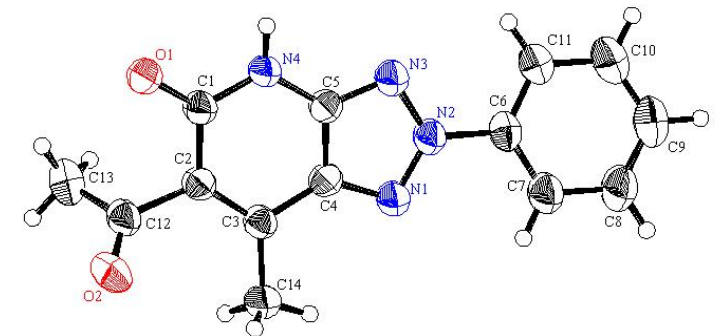
Figure 3. ORTEP plot of the x-ray crystallographic data determined for 20f . Crystallo- graphic data have been deposited in the Cambridge Crystallographic Data Centre as supplementary publication number CCDC 815380